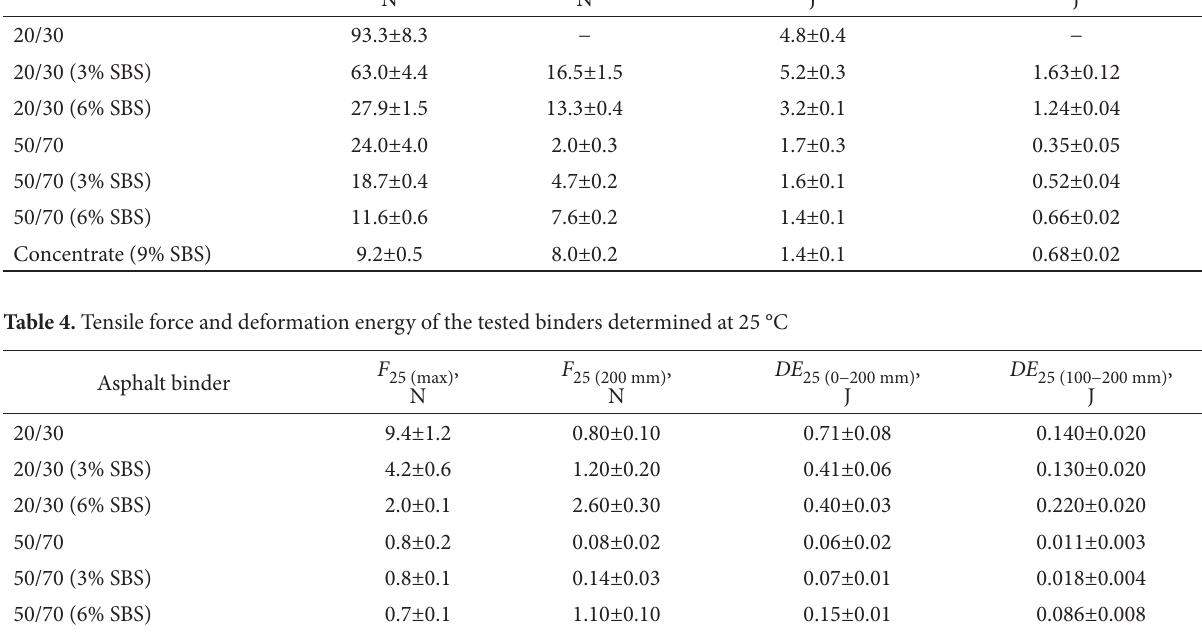
Table 3. Tensile force and deformation energy of the tested binders determined at 10 °C Asphalt binder